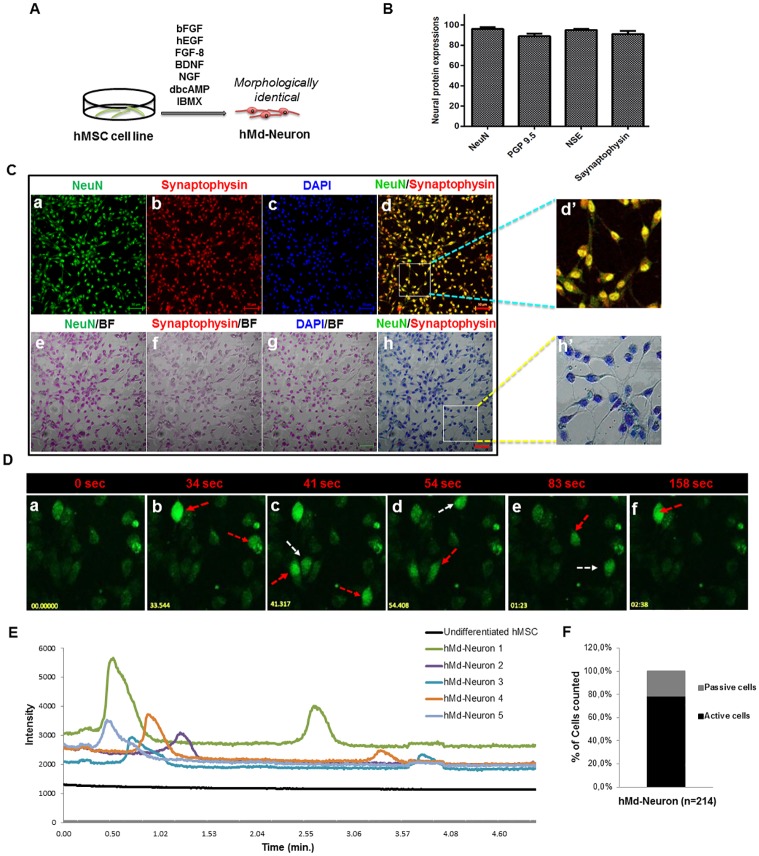
hMSC cell line from bone marrow has the ability to differentiate into spontaneously active neurons (A) Schematic representation of neuronal induction on hMSC cell line. (B) Plot indicates neuronal markers expression percentages of hMd-Neurons from hMSC cell line after neuronal induction during 12 days and almost %100 of neuronal induced cells express neuronal maturation proteins NeuN, Synaptophysin, NSE and PGP 9.5. Positively stained cells counted from 10 different area of staining and averages were calculated. Functionality of hMd-Neurons was evaluated upon labeling with Fluo-4 for real time Ca++ ion imaging without any outside stimulation chemically. (C) Immunofluorescence co-staining of hMSC cell lines in neuronal induction medium; NIM composed of NGF, BDNF, FGF-8, bFGF, EGF, dbcAMP, IBMX, B27 for 12 days reveals the presence of neuronal maturation proteins NeuN (a, e) and Synaptophysin (b, f) with DAPI nuclear staining (c, g). Merged images represent positive co-staining of NeuN and Synaptophysin for each individual cell (d, h). Dashed yellow squares magnified 3 folds (d’, h’). (D) Florescent images (a-f) demonstrates time dependent firing pattern of hMd-Neurons from hMSC cell line through imaging of Ca++ ion kinetics and arrows indicate firing of each hMd-Neuron separately (sec; seconds). (S1 Video) (E) Histogram indicates firing frequency and signal intensity of each individual hMd-Neuron while there is no signs of spontaneous activity from uninduced hMSCs. According to Ca++ influx/efflux through hMd-Neurons, (F) 78.5% of cells were recorded as spontaneously active with twice firing frequency in 4 minutes. Data are represented as mean ± S.E.M. Scale bars represent 50 μm.